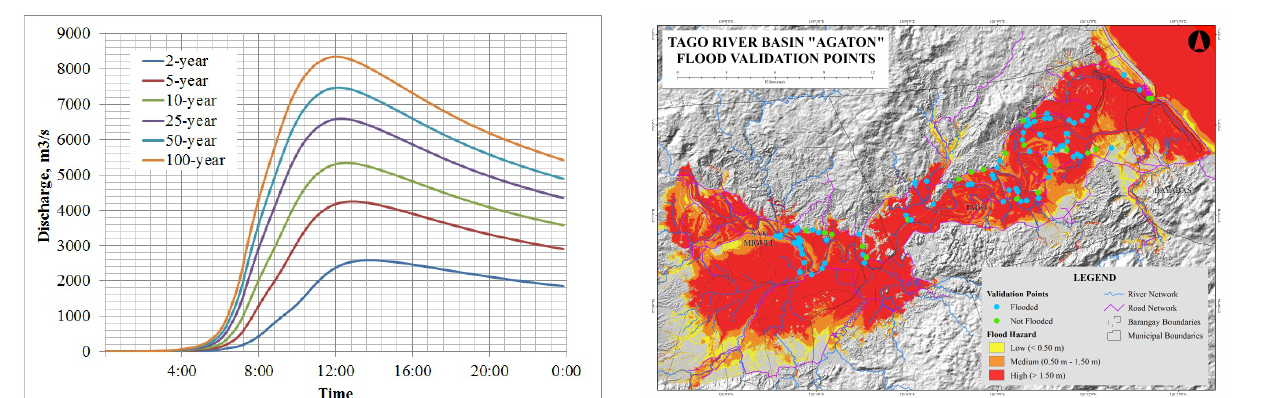
Figure 6: 24-hour outflow hydrographs generated at Cabtik Bridge station for the 6 rain return periods.